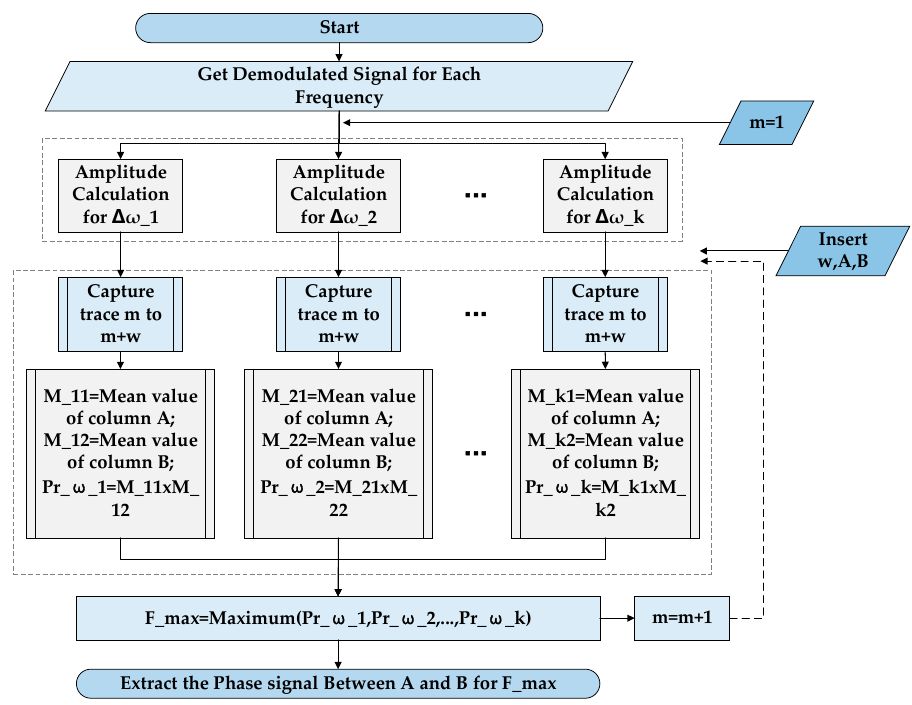
Figure 4. The flowchart for predicting the best phase signal. W is averaging window size, A and B are locations for two sides of the gauge, k is the number of independent frequencies, m is a